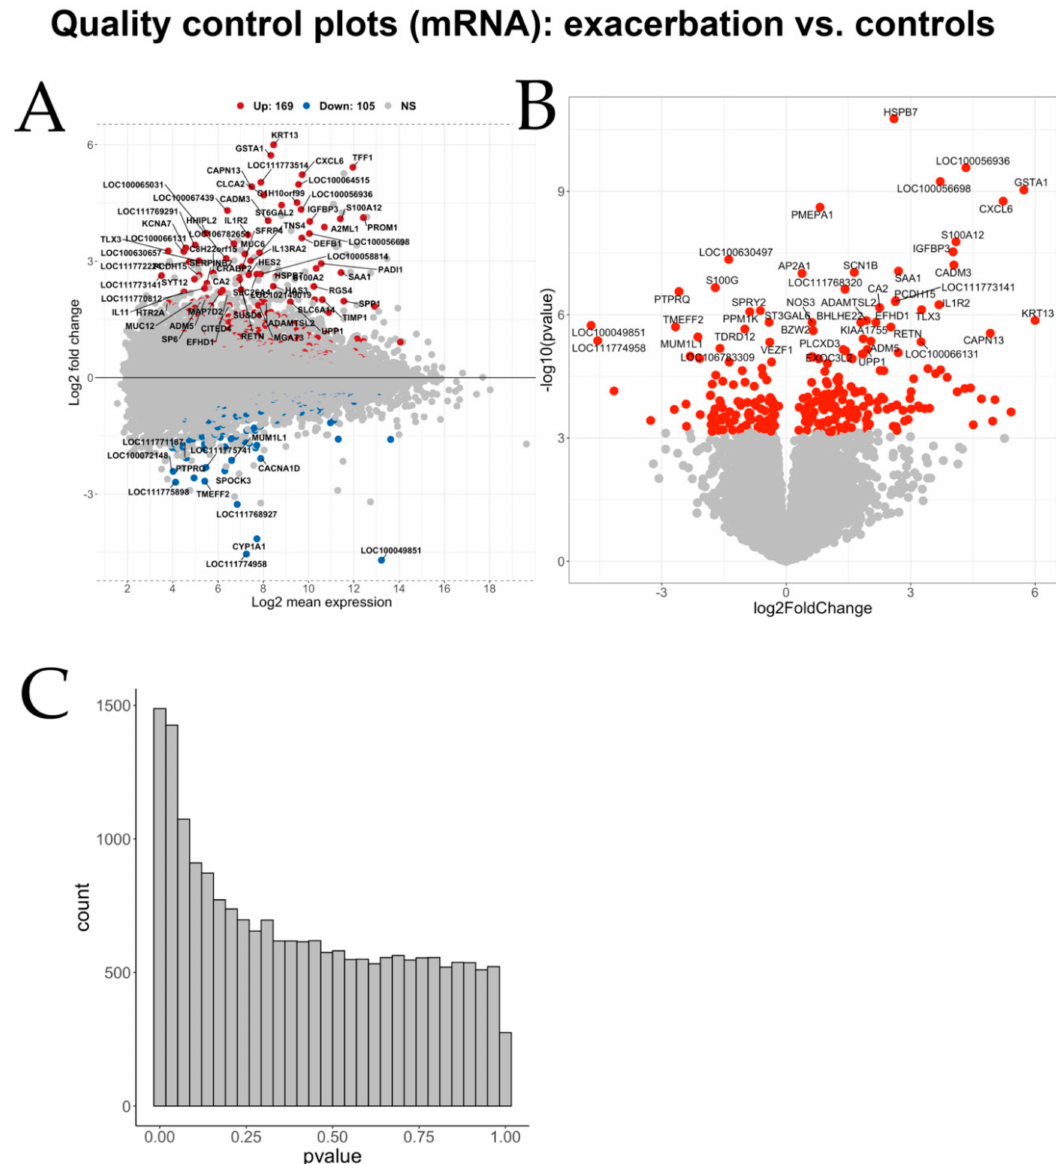
Figure A9. Quality control plots for the di ff erential mRNA expression analysis using the contrast of horses in exacerbation vs. healthy control horses. An MA-plot ( A ), a Volcano plot ( B ), and a histogram of the obtained p -values ( C ) are shown. Non-significant (NS) genes are indicated in grey